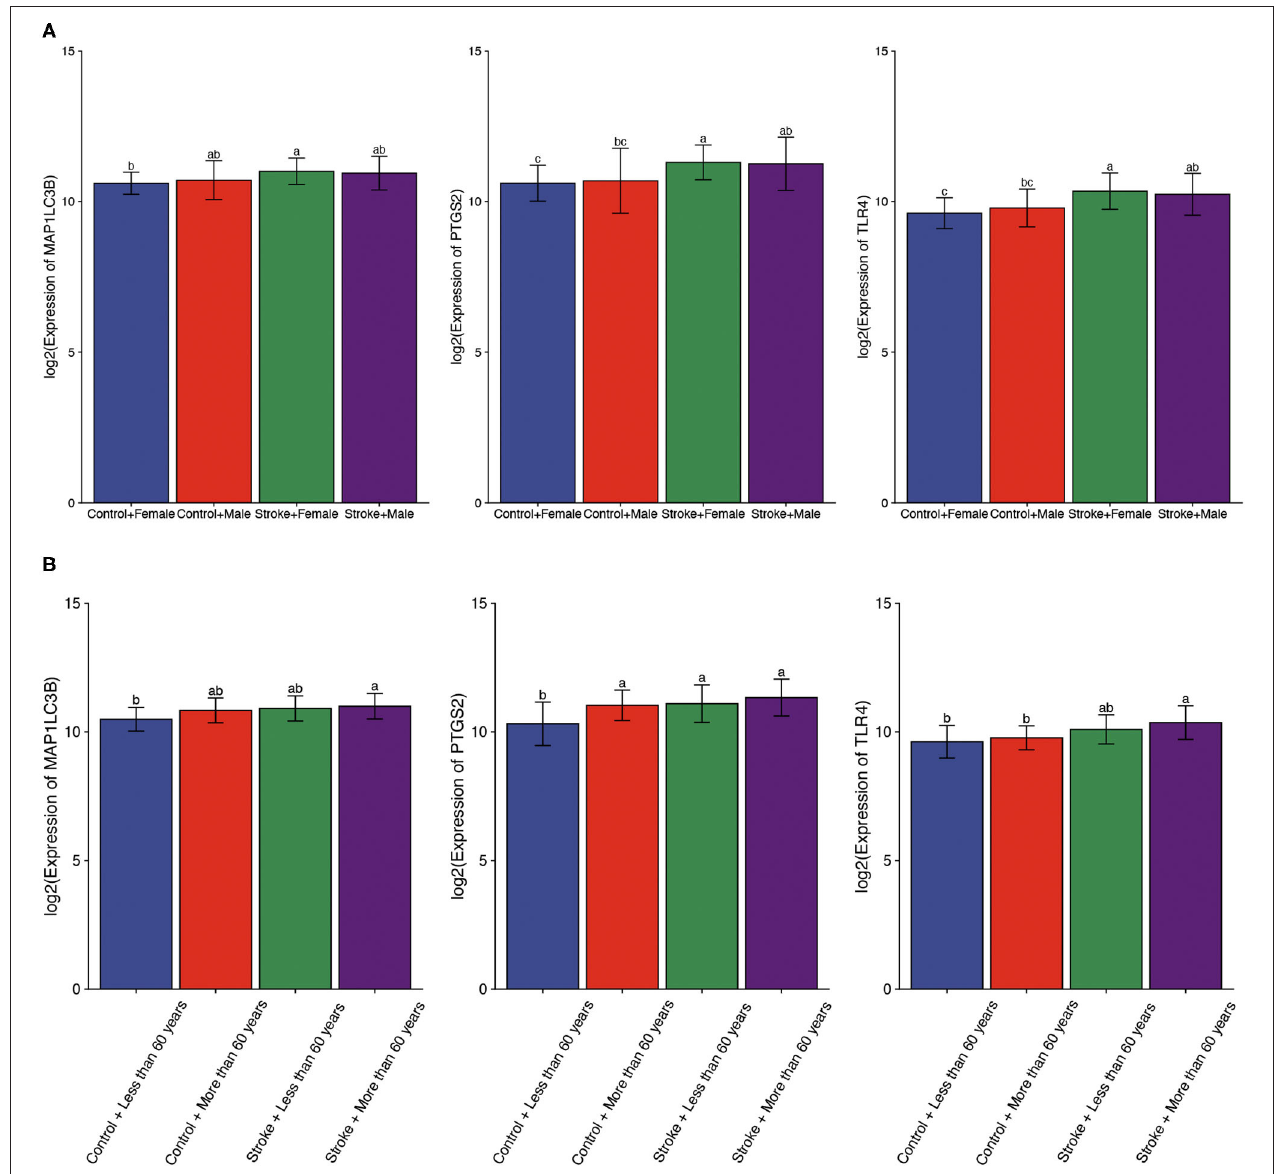
FIGURE 5 | The expression of ferroptosis-related biomarkers in a subgroup of ischemic stroke. (A) The expression of ferroptosis-related biomarkers in different genders of ischemic stroke patients. (B) The expression of ferroptosis-related biomarkers in different ages of ischemic stroke patients. a, variance variance; b, variance analysis; c, common